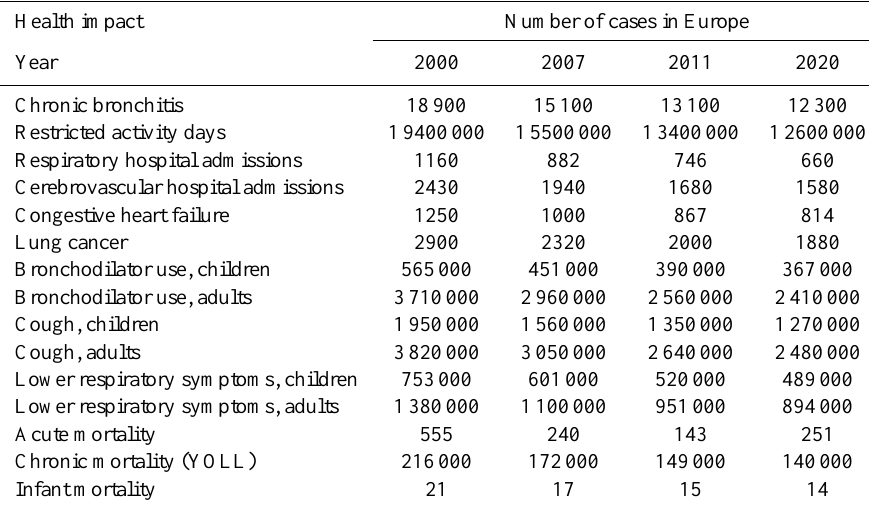
Table 3. Total number of cases in Europe of the different impacts related to international ship traffic in the Baltic Sea and the North Sea (scenario: BaS-NoS/15) for the four different